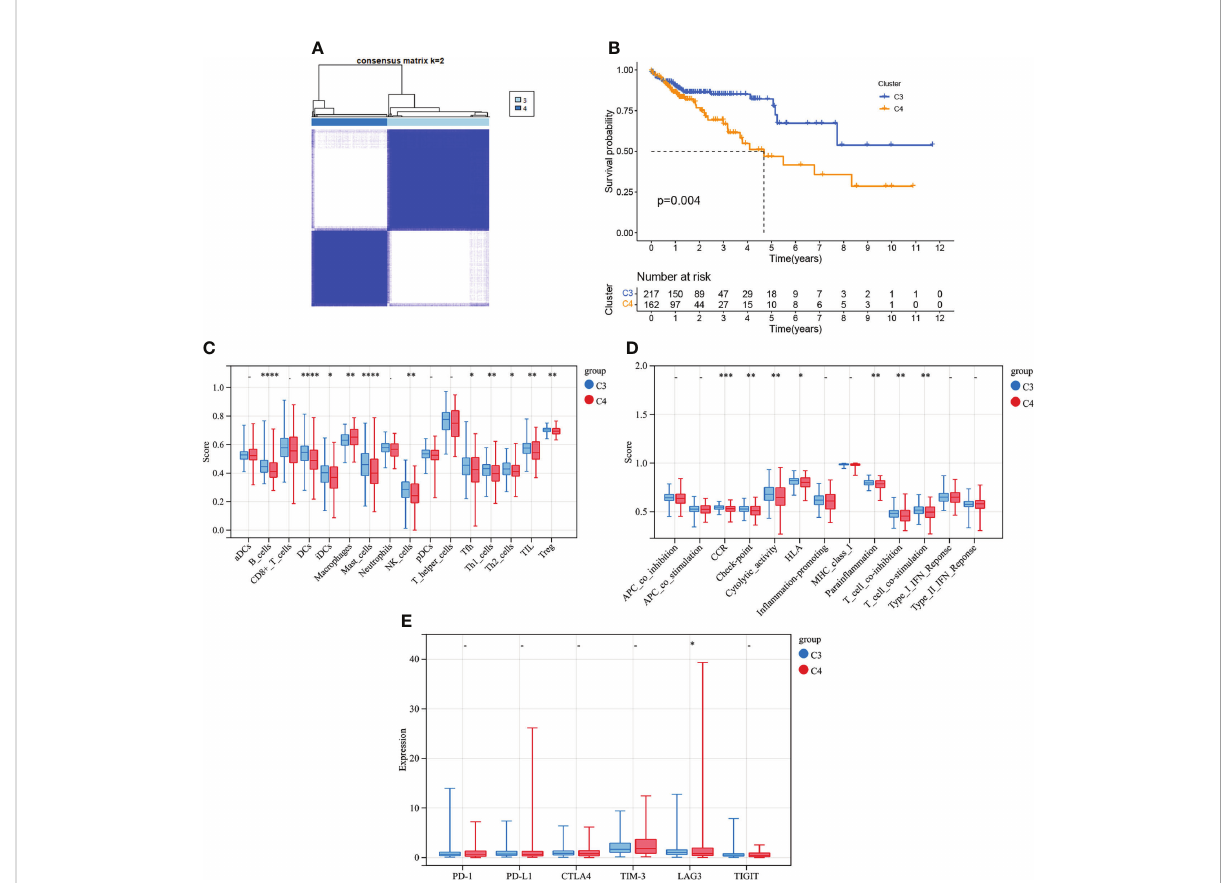
FIGURE 7 Tumor classi fi cation based on the CMRGs-related gene. (A) COAD patients were grouped into two clusters according to the consensus clustering matrix (k = 2). (B) Kaplan – Meier curves for the two clusters. (C) Relative in fi ltration of 16 types of immune cells in CMRGs-related gene cluster C3and C4. (D) Relative enrichment scoreof 13immune related functions in CMRGs-related gene clusterC3and C4. (E) Differences in expressionof immune checkpoint - related genes between C3and C4. 0 ≤ ****<0.0001 ≤ *** < 0.001 ≤ **< 0.01 ≤ * < 0.05 ≤ . <